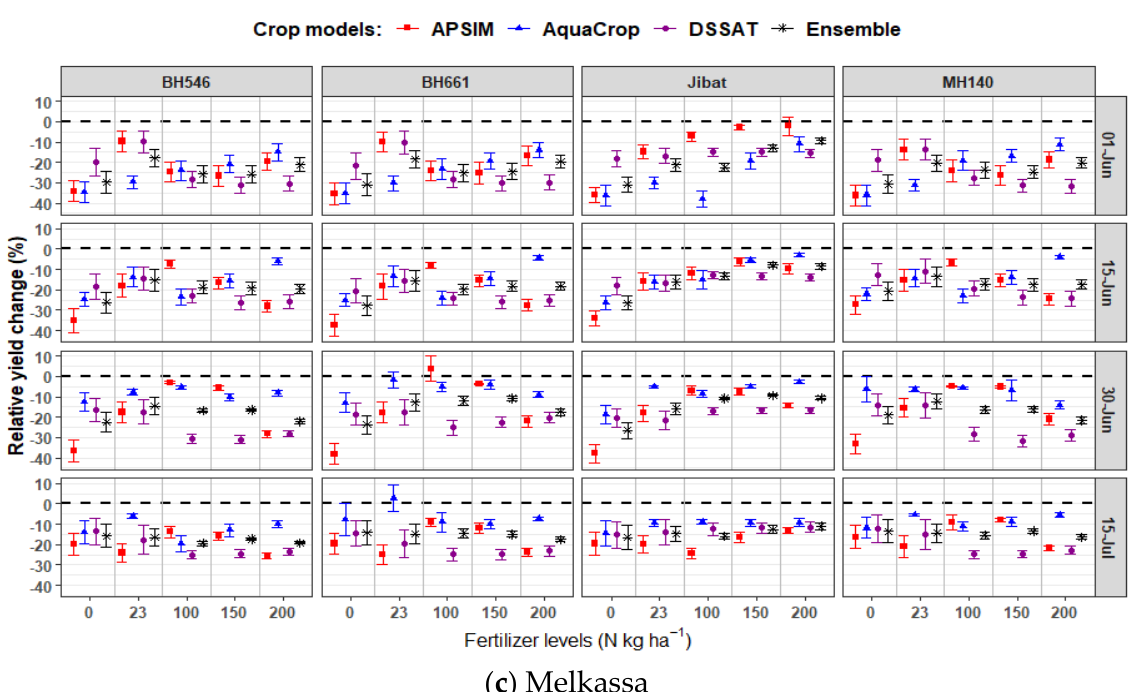
Figure 6. Effects of planting dates on mean maize yield under future climate change scenarios relative to the baseline for ( a ) Ambo (high altitude), ( b ) Bako (mid-altitude), and ( c ) Melkassa (low altitude) as simulated using the APSIM, AquaCrop, and DSSAT crop models. Error bars show the standard deviation of the change of maize yield simulated for multiple GCM projections.